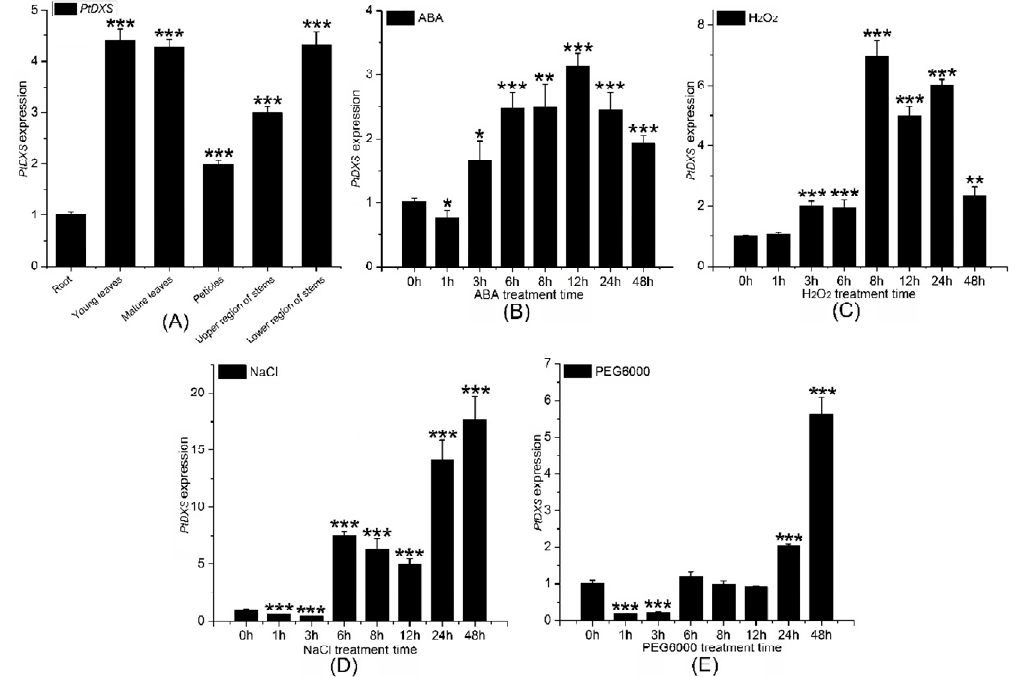
Figure 4. Comparison of PtDXS expression in various tissues and in response to stresses. ( A ) Comparison of the PtDXS expression in the indicated tissues. Comparison of the PtDXS expression level in young leaves followed by different treatments and times ( B ) 200 µ M ABA, ( C ) 2 mM H 2 O 2 , ( D ) 200 mM NaCl, and ( E ) 10% PEG6000. All experiments have been normalized by β actin as an internal reference; bars represent means ± standard deviation (SD; n = 3); three independent biological experiments were performed with three repeats; asterisks represent significant differences in comparing with 0 h treatment as the control (Student’s t -test; *, **, and ***, p < 0.05, p < 0.01, and p < 0.001, respectively).